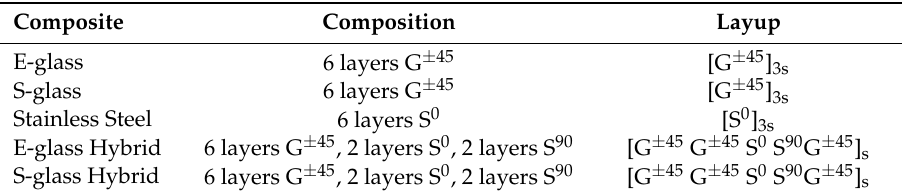
Table 1. Composition of prepared composites.